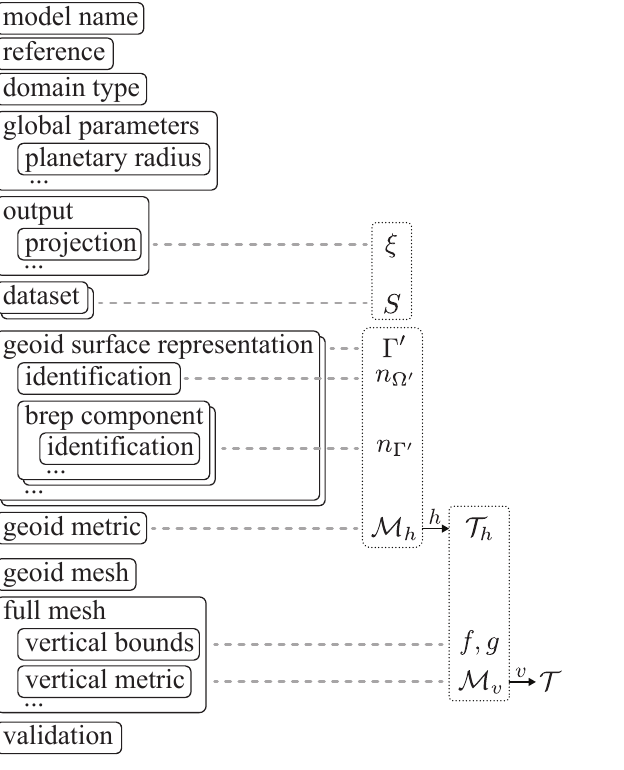
Figure 3. Overview layout of the geophysical domain mesh con- straint description highlighting extensible dynamic components and correspondence to source data S , projection ξ , and constraints